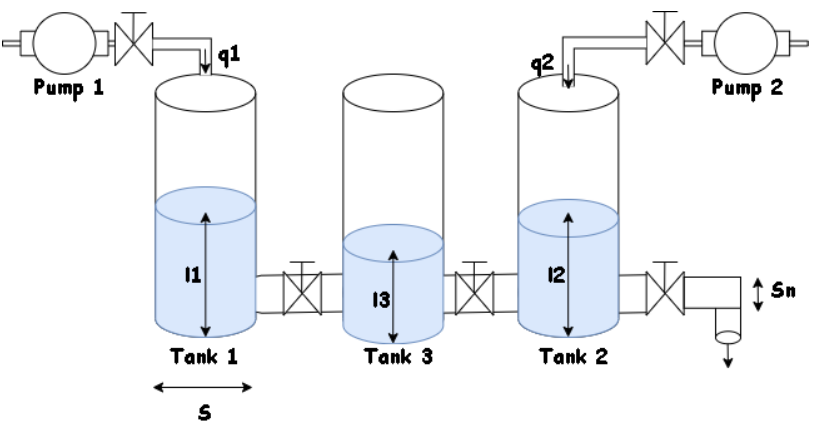
Figure 10. Schematic diagram of the three-tank system.